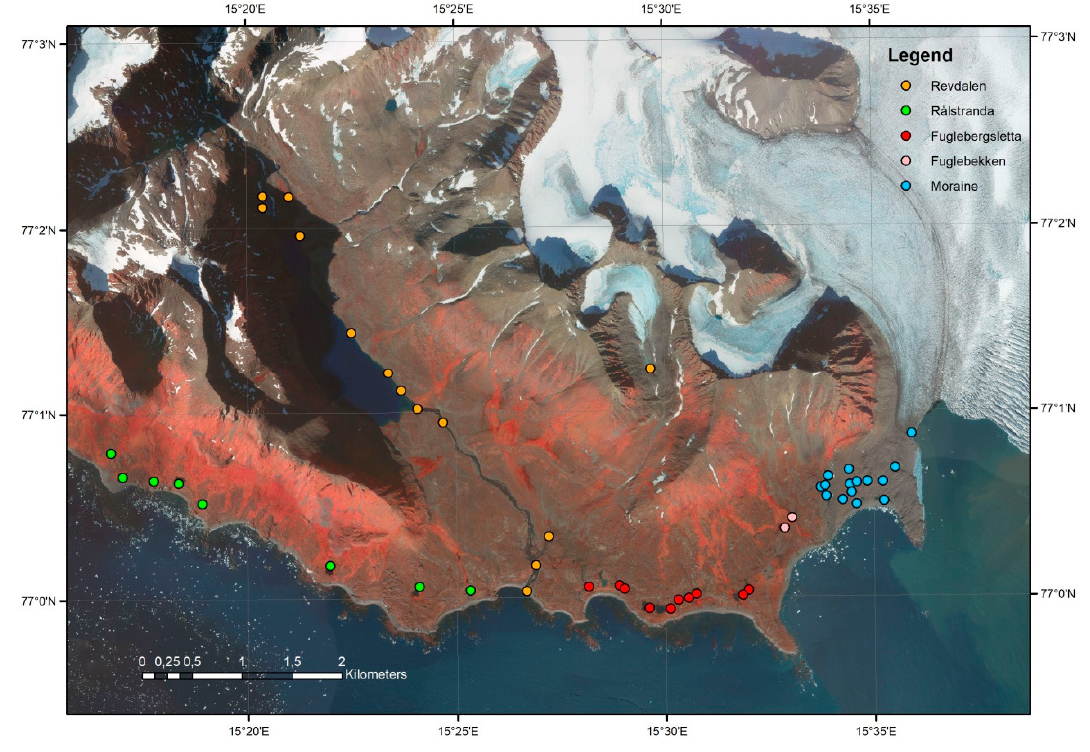
Figure 1. Sampling points in the Hornsund fjord area, divided into five regions (background map [27]).